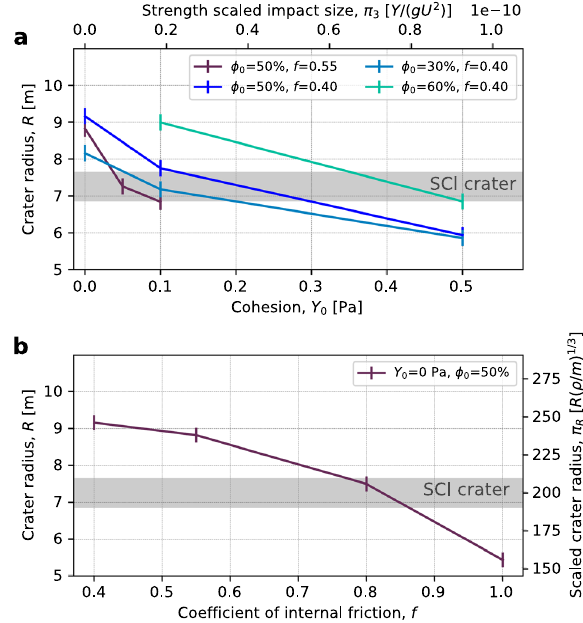
Fig. 1 | Crater radius as a function of material properties. a Crater radius as a function of cohesion Y 0 for different friction coef fi cients ( f =0.4 and f =0.55) and porosities (30,50, 60 %). b Crater radius asa function ofthe coef fi cient of internal frictionfor50%porous,cohesionlesstargets( Y 0 =0).Thehorizontallineshowsthe measured SCI crater size at the pre-impact level (7.25±0.8 m), with its associated error 2 . Source data are provided as a Source Data fi